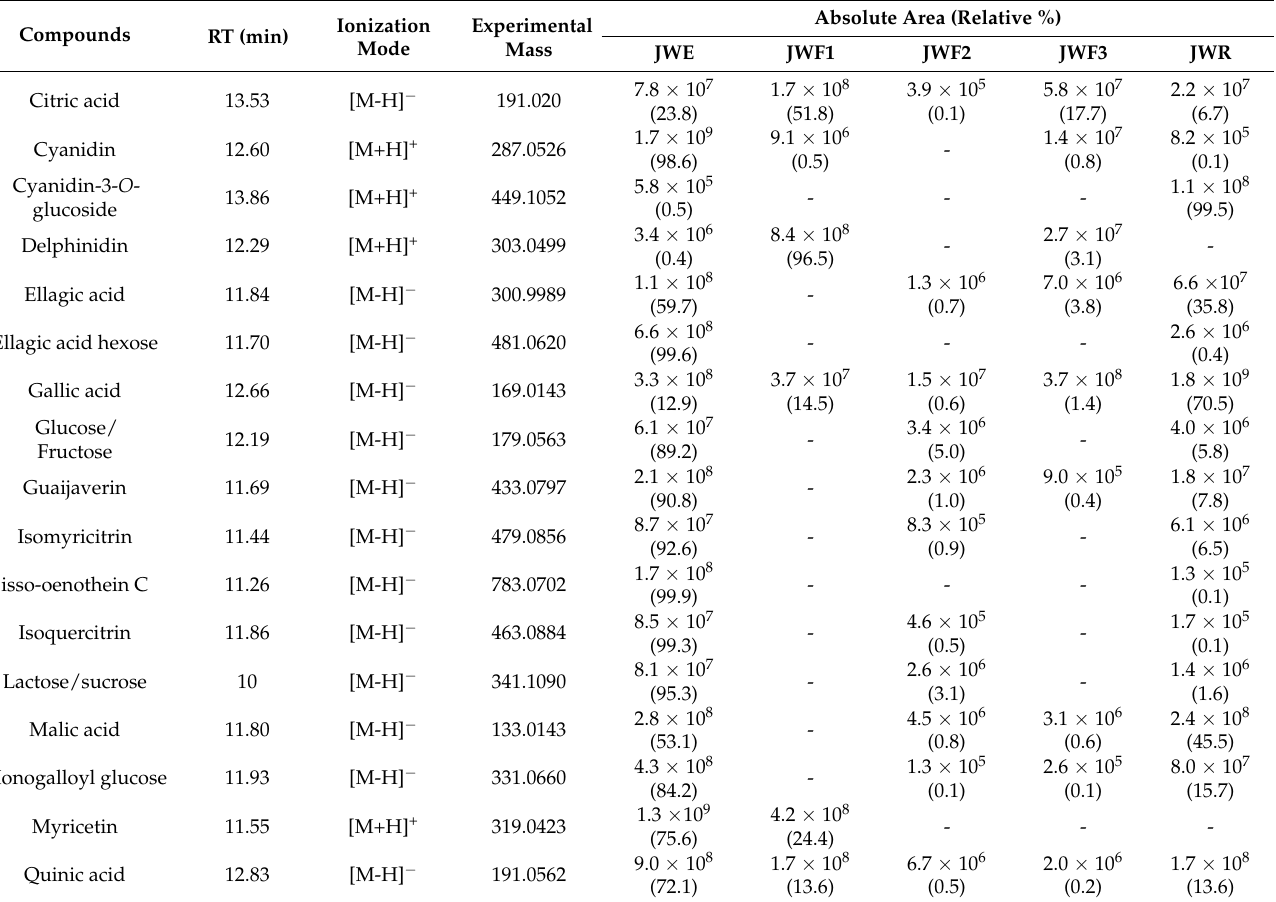
Table 3. Chemical profile of jabuticaba wine extracts determined by LC-HRMS/MS analysis. Relative areas were calculated among samples. The peak area in each sample was divided by the sum of peak areas among the samples to show compound